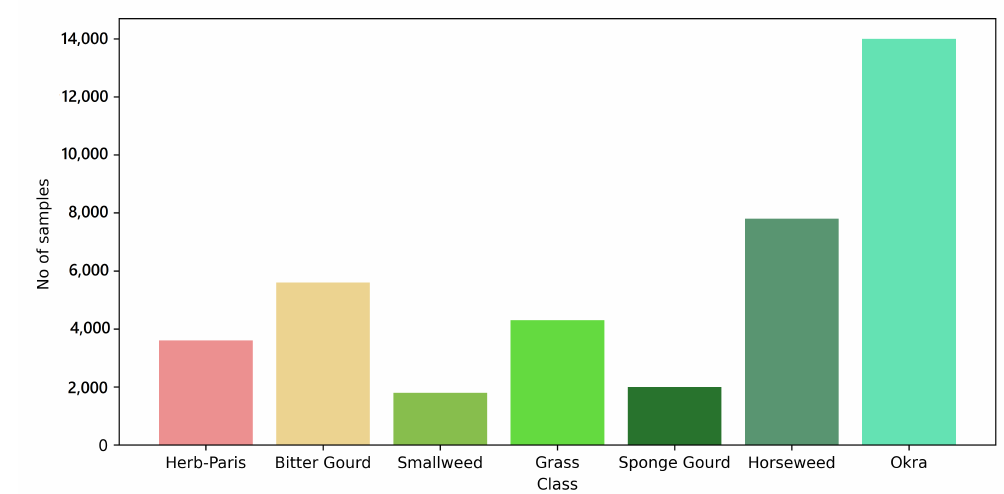
Figure 4. The dataset is represented in a bar graph, where the frequency of each class is depicted. The graph reveals that okra has the most number of samples, while smallweed and sponge gourd have a lower count of instances.